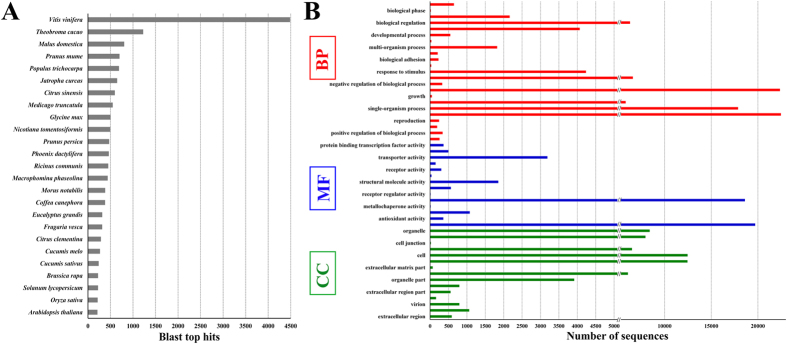
Annotation of the SDM transcriptome.(A) Top 20 species distribution of the SDM transcriptome showing the abundance of sequences. (B) Go category distribution of SDM transcripts among level 1 GO categories: biological process (BP), molecular function (MF), and cellular component (CC).